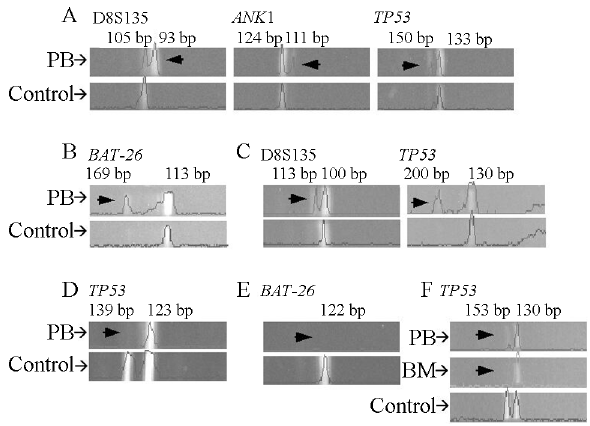
Figure 1 - Demonstration of MSI and LOH in AML and CML patients. MSIeventsarerepresentedforCMLpatientsC07(A)andC17(B)andfor AML patient A11 (C). LOH events are represented for AML patients A24 (D), A28 (E), and A23 (F). MSI and LOH were assessed by comparison of the microsatellite alleles amplified from peripheral blood (PB) and bone marrow (BM) with alleles from buccal cells (control). Arrows indicate gain of new alleles (MSI) or allele loss (LOH) as compared to control DNA. MSI of patient A20 for locus D7S486 is not